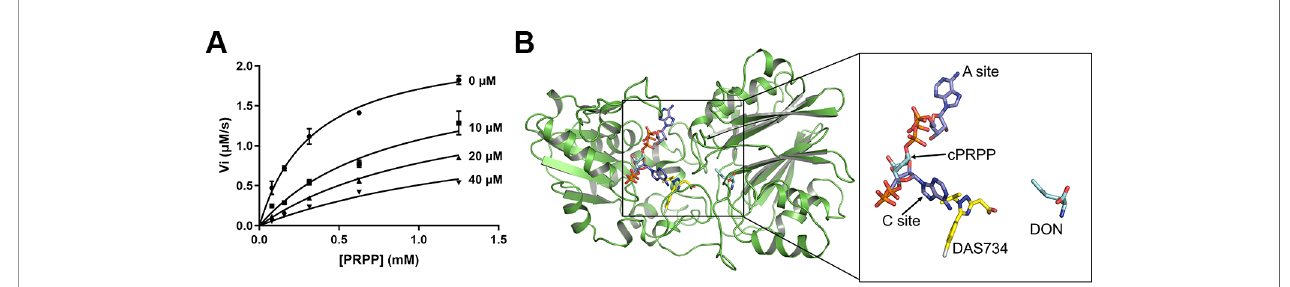
FIGURE 3 | The inhibition mode of DAS734 on AtGPRAT2. (A) Inhibition kinetics showing that DAS734 is a competitive AtGPRAT2 inhibitor with respect to phosphoribosyl pyrophosphate (PRPP). The labels indicate different DAS734 concentrations. The data was fi tted to the mixed inhibition model in GraphPad Prism software, and the alpha value of 12.56 calculated by this model indicated a competitive inhibition. Error bars are standard error of the mean (SEM) values of three independent experiments. (B) Structural superimposition of AtGPRAT2 with docked DAS734, EcGPRAT in the active [Protein Data Bank (PDB): 1ECC] and BsGPRAT in the inactive conformation (PDB: 1GPH). The cPRPP and 6-diazo-5-oxo-L- nor -leucine (DON) in the structure of 1ECC are shown as cyan sticks. The two AMP molecules in the A and C sites are shown as slate sticks. The docked DAS734 is shown in yellow sticks with the chlorine atom colored